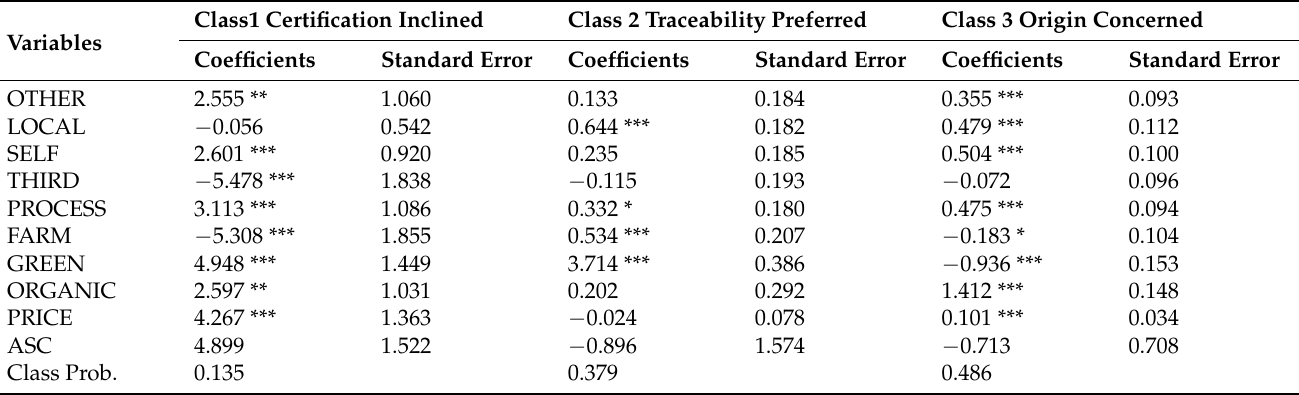
Table 4. Famers’ preference heterogeneity for different food safety information labels.